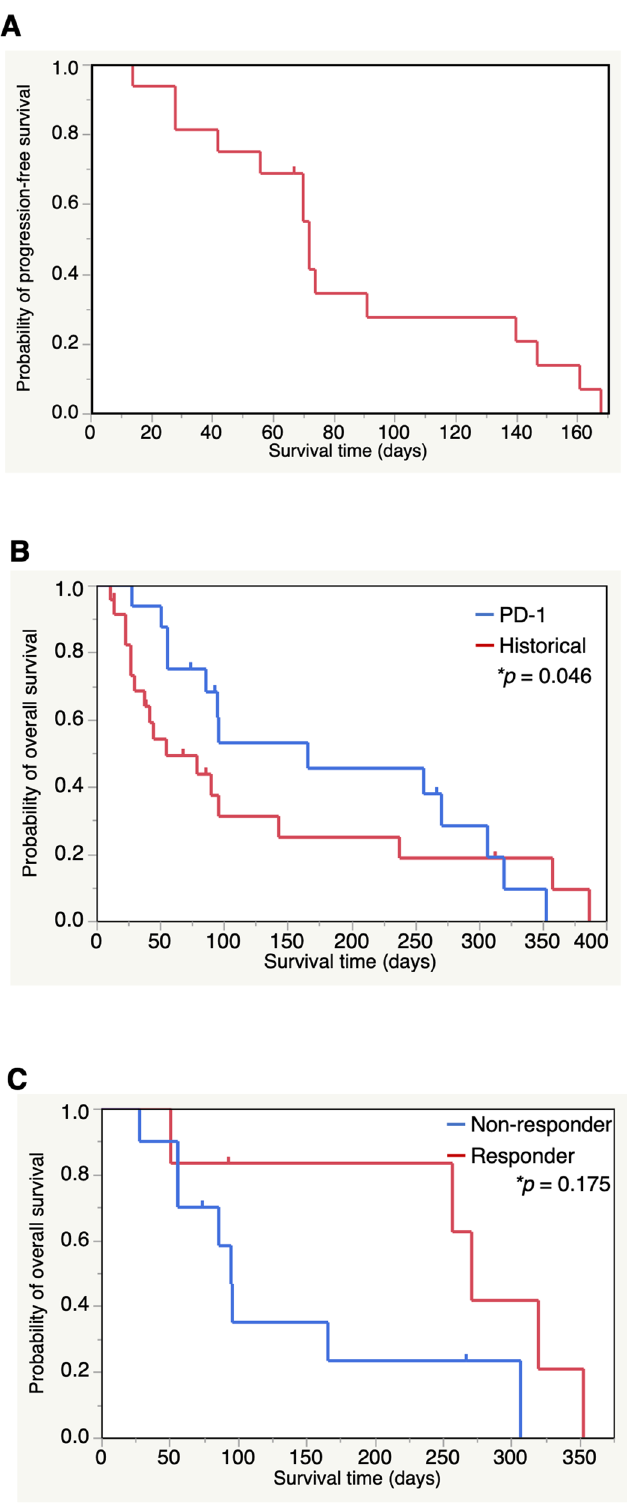
Figure 5. Kaplan–Meier survival curves of Stage IV oral malignant melanoma cases who received with anti-PD-1 antibody. ( A ) Kaplan–Meier curve shows the progression-free survival (PFS) of 16 dogs with Stage IV oral malignant melanoma (OMM). PFS was measured from initiation of treatment until disease progression or death, whichever occurred first. Data from one case without an event was censored at the last date of disease assessment. ( B ) Comparison of overall survival (OS) between 16 dogs with Stage IV OMM who received anti-PD-1 antibody (blue line) and historical controls including 23 dogs with Stage IV OMM who received standard therapy in our veterinary teaching hospital (red line). ( C ) Kaplan–Meier curve of OS for dogs in ( B ) that had less than 20% of maximum tumor reduction by anti-PD-1 antibody (responder group, n = 6) versus the remaining cases (non-responder group, n = 10). ( A – C ) Tick marks on lines indicate censored data. Statistical difference was calculated using the Wilcoxon